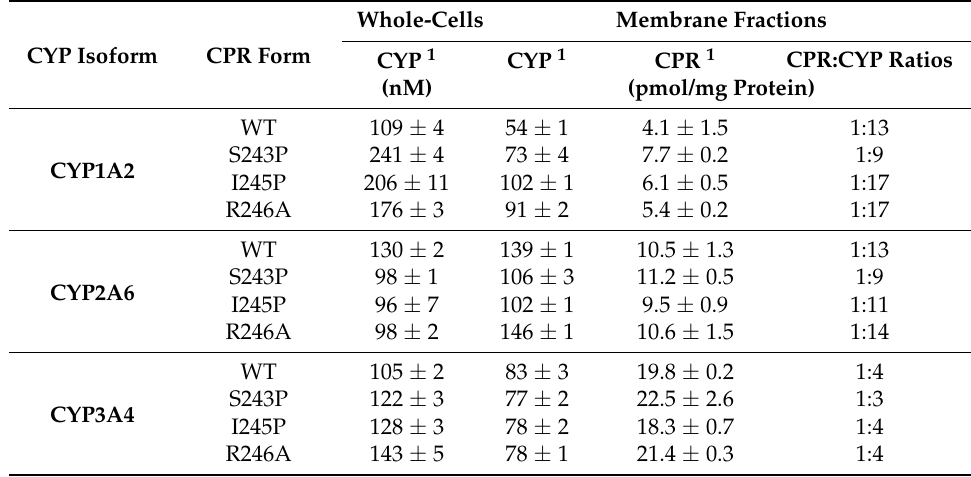
Table 1. Microsomal cytochrome P450 (CYP) and NADPH cytochrome P450 oxidoreductase (CPR) contents of BTC cultures and membrane